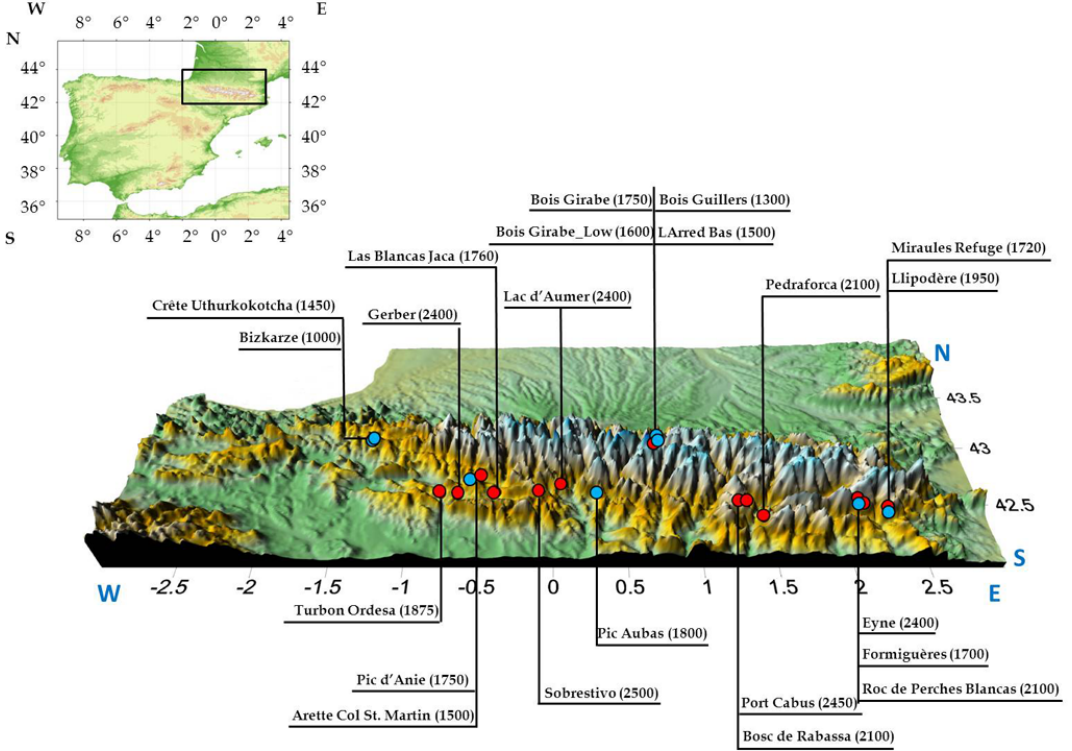
Fig. 1. Location of the 22 MXD chronologies. Red and blue circles indicate the tree species sampled at each site: Pinus uncinata and Abies alba , respectively. The elevations (in ma.s.l.) are indicated in